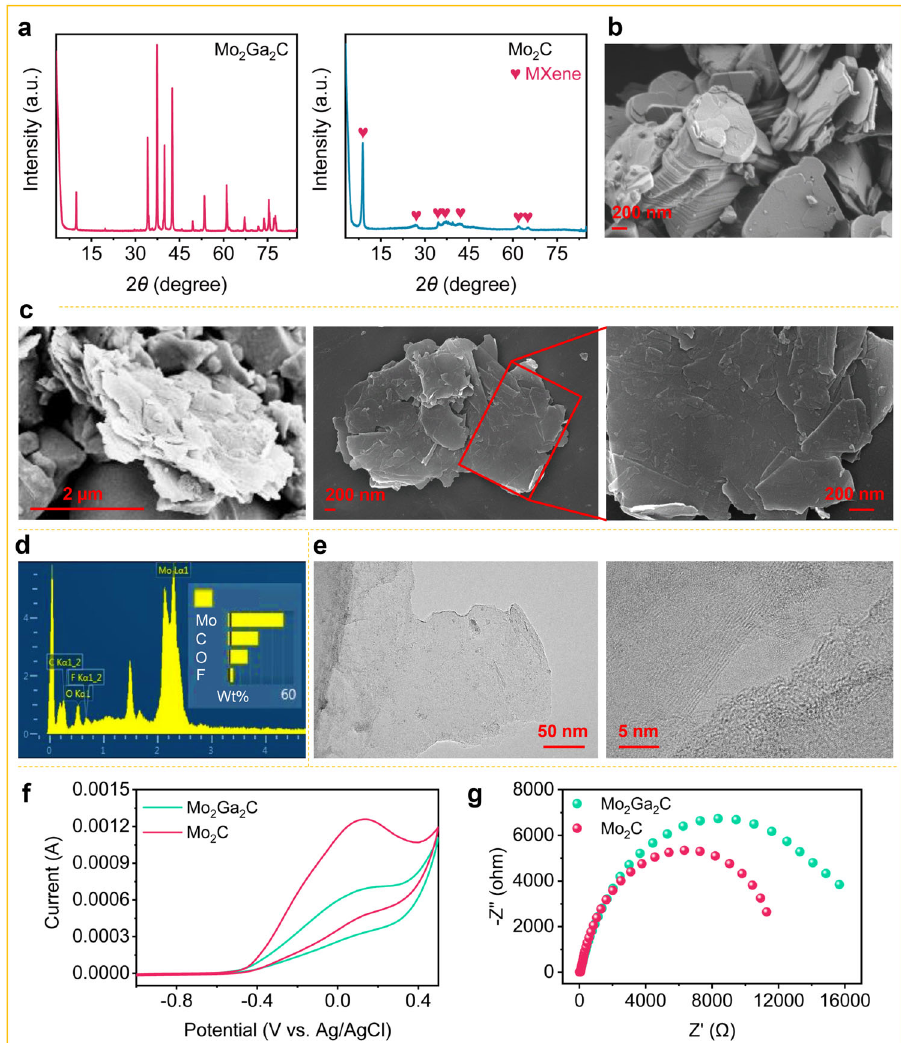
Fig. 1 Phase and morphology analysis. a Morphological analysis of Mo 2 Ga 2 C and Mo 2 C MXene by X-ray diffraction (XRD). b Scanning electron microscopy (SEM) image of Mo 2 Ga 2 C. c SEM images of Mo 2 C MXene. d SEM-EDS of Mo 2 C MXene. e Transmission electron microscopy (TEM) images of Mo 2 C MXene. f Cyclic voltammograms of Mo 2 Ga 2 C and Mo 2 C MXene. g Nyquist plots of Mo 2 Ga 2 C and Mo 2 C